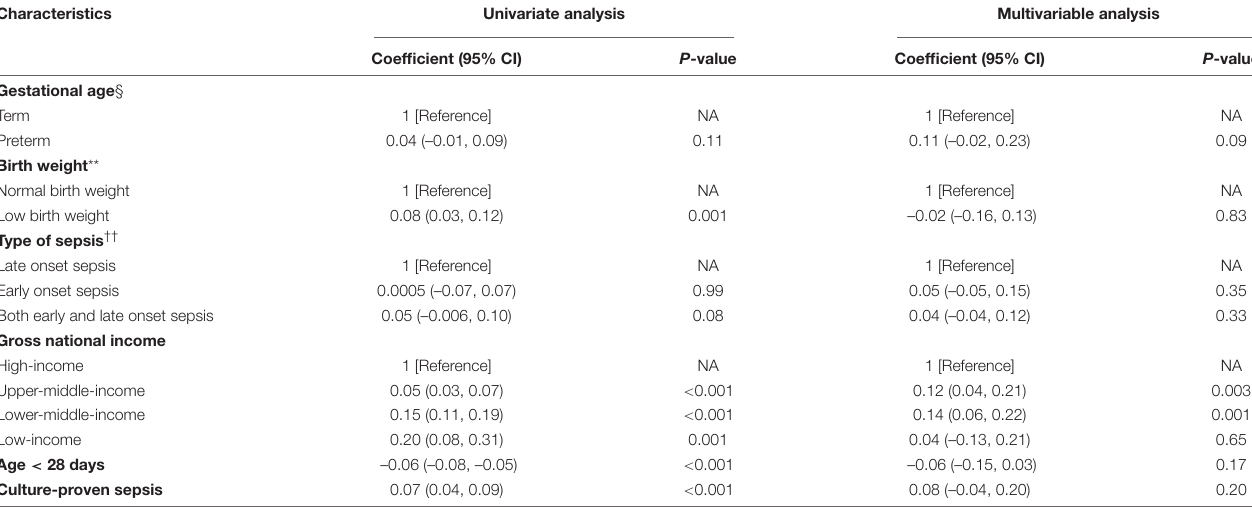
TABLE 5 | Meta regression predicting Case Fatality Rates among infants less than 90 days.